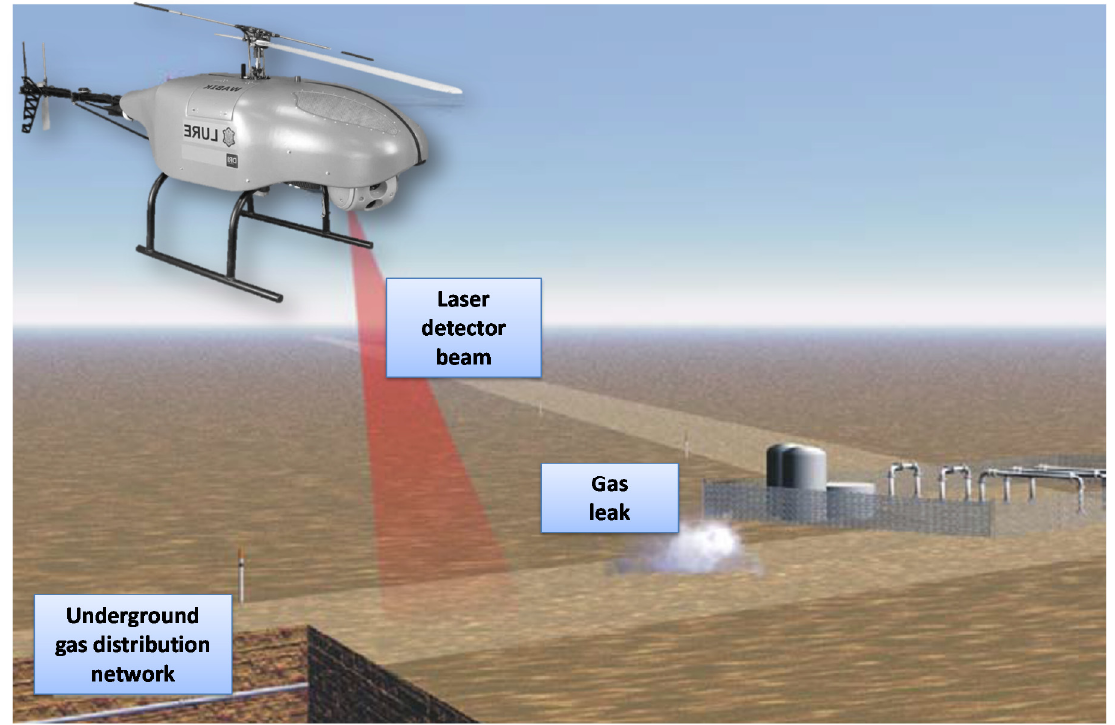
Figure 13. Remote sensing system in use to detect gas leaks from pipelines.